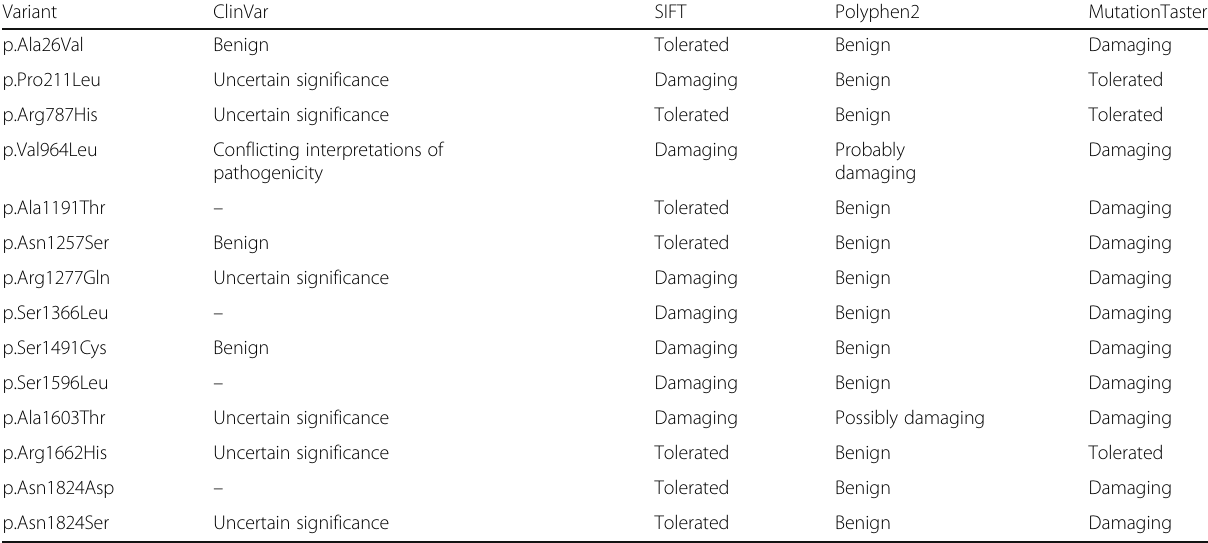
Table 2 The interpreted results of the risk assessment of various reported